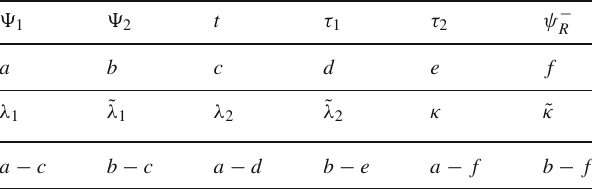
Table 1 Spurionic U ( 1 ) assignment for the couplings and